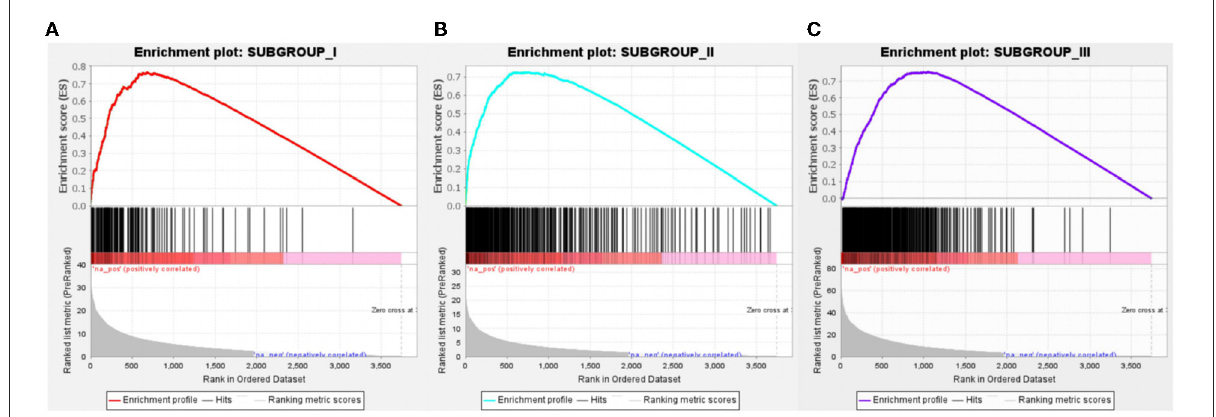
FIGURE7 Gene Set Enrichment Analysis of subgroup-specific upregulated genes. (A) Compared to the ND group, specific genes in subgroup I was significantly upregulated, n = 149. (B) Compared to the ND group, specific genes in subgroup II were significantly upregulated, n = 403. (C) Compared to the ND group, specific genes in subgroup III were significantly upregulated, n = 491. FDR < 0.001.